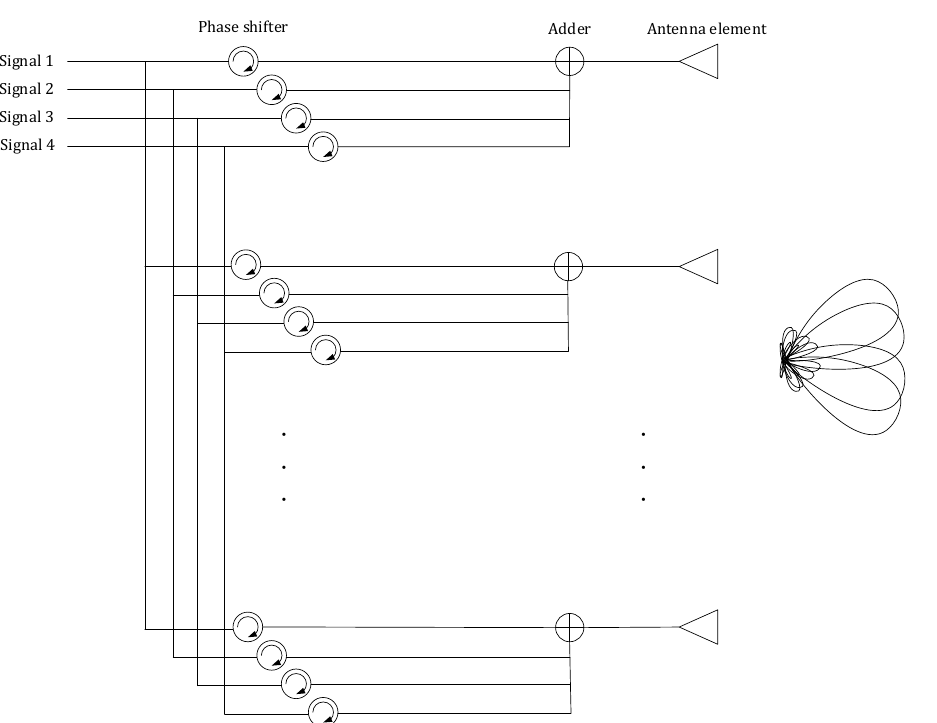
Figure 9. Schematic diagram of the proposed system in elevation direction.